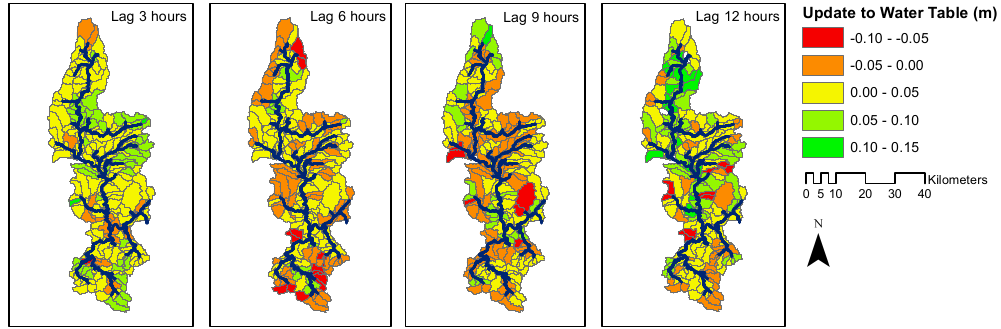
Fig. 14. Size of REnKF update to model state “depth to water table” for the Pomahaka catchment, by subcatchment and lag time, at obser- vation time 23 February 2012, 06:00:00LT.